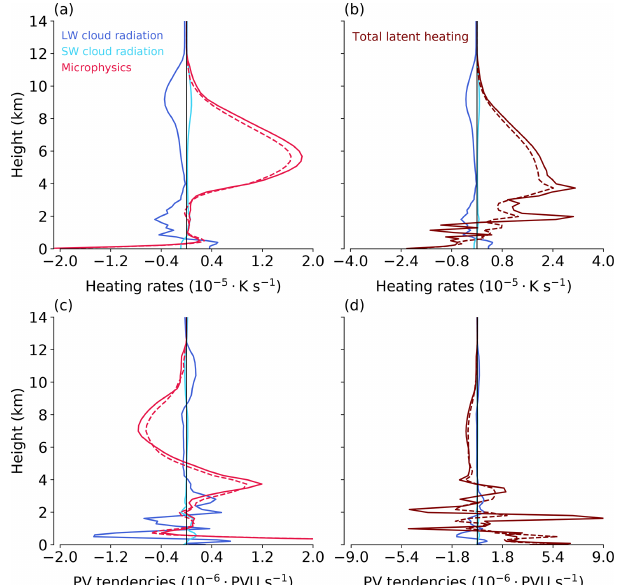
Figure 7. Vertical profiles of spatially averaged (a) cloud radia- tive and microphysical heating rates averaged between days 5 to 8. Panel (b) further shows the total latent heating calculated as the sum of cloud microphysical heating and heating from saturation ad- justment. Panels (c) and (d) show the associated PV tendencies. The solid lines are for the CRH simulation, and the dashed lines are for REF